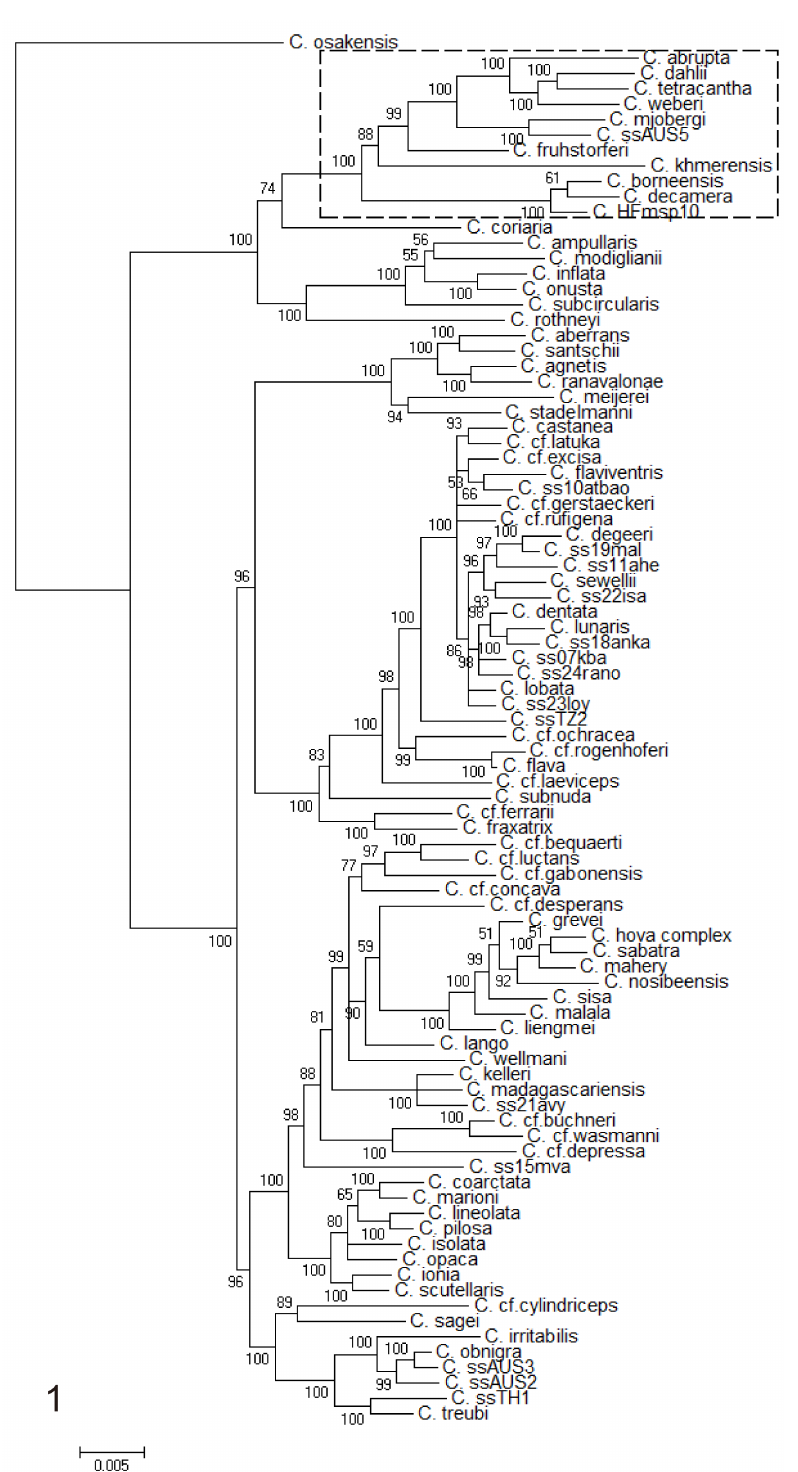
Fig. 1. Bayesian majority rule consensus tree reconstructed for 90 taxa using five genes (ArgK, CAD, LWRh, Top1, Wg) in a MrBayes analysis. Above node numbers indicate posterior probability. Data were partitioned by PartitionFinder v.1.1.1 and analyzed using a best fit model for each gene and codon position, with 10 million generations and a burn-in of 25 %. Area enclosed by dashed lines is enlarged on Fig.